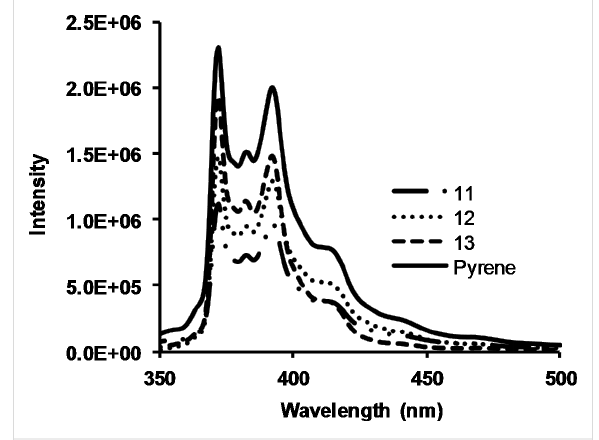
Figure 1: Fluorescence of a saturated aqueous solution of pyrene after 30 min exposure to dendrimers 11 – 13